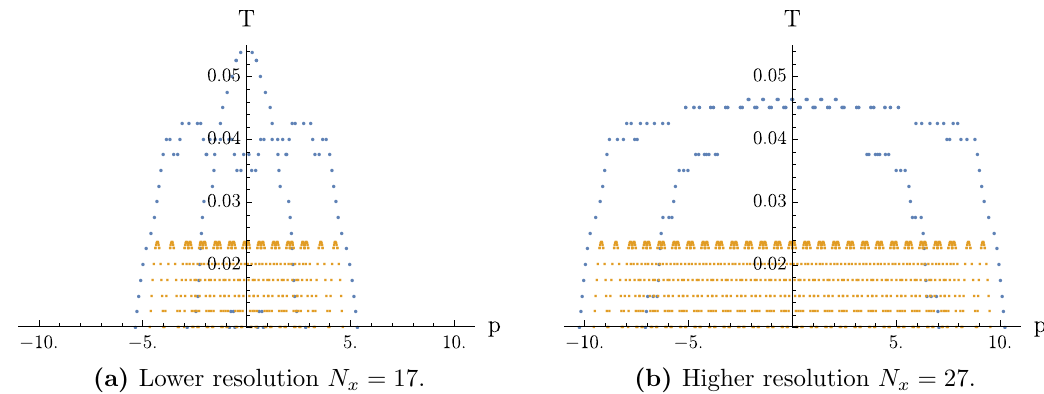
Figure 10 . Sample results for the eigenvalue search for the backgrounds with k = 0 : 7 and two amplitudes: A = 0 (yellow dots) and A = 2 : (blue